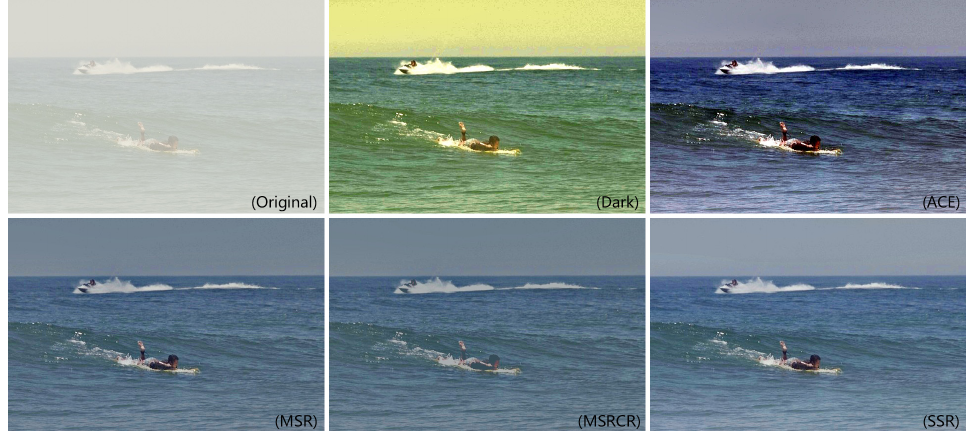
Figure 2. The comparison of dehazing effects with various algorithms.